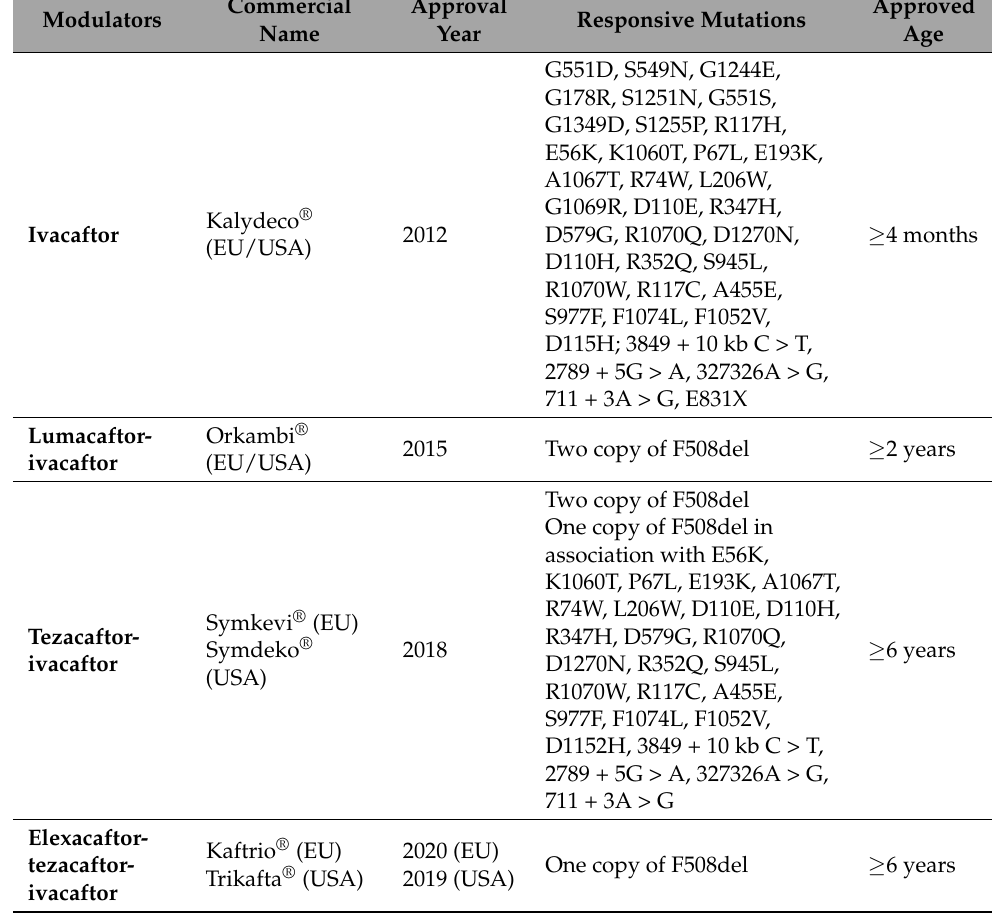
Table 1. Approved CFTR modulators and their